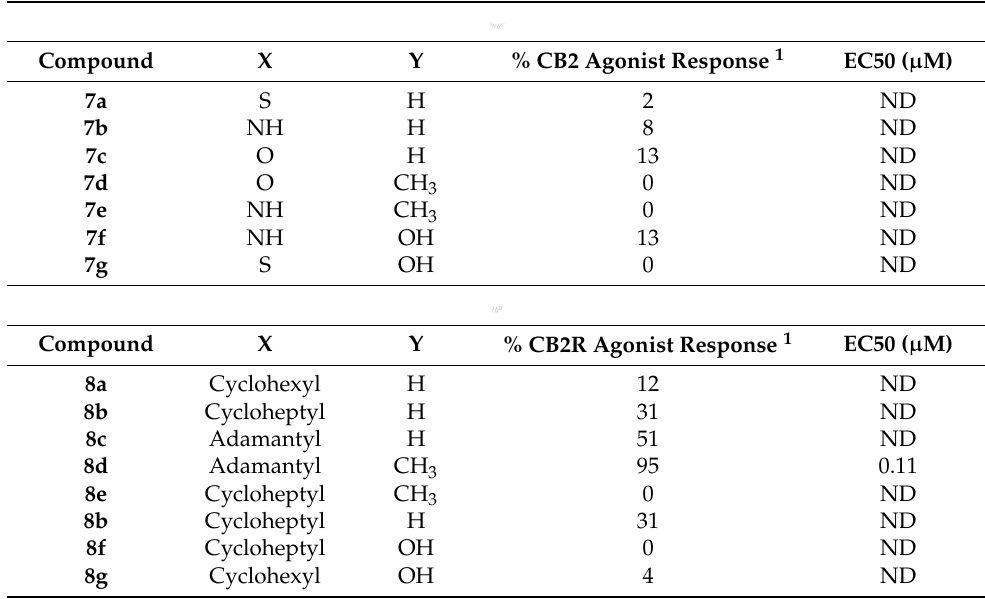
Table 1. Synthesized target compounds and human CB2R agonist effect for derivatives 7 and 8 at a concentration 10 µ M.